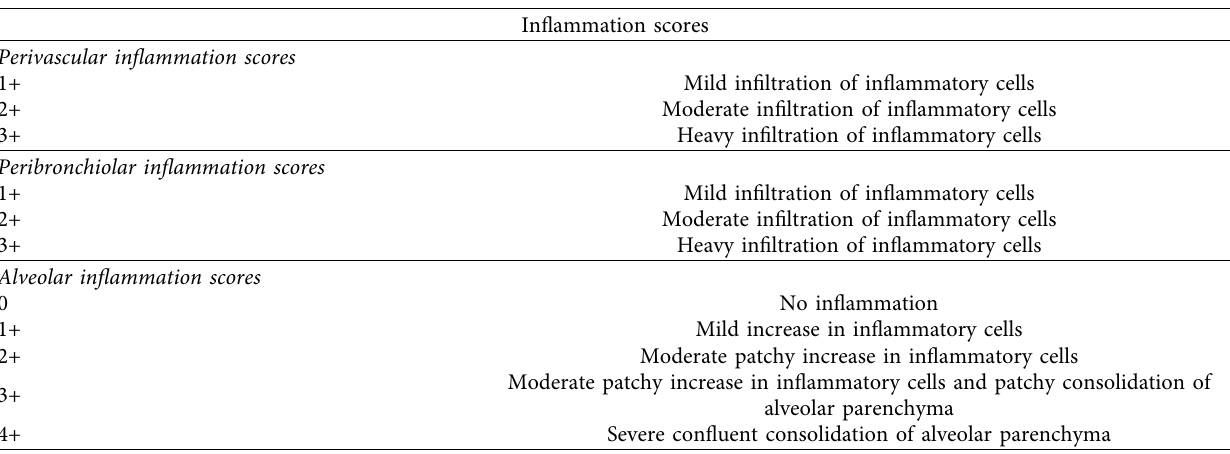
Figure 1: Te schematic diagram of bleomycin infusion protocols in sheep ( n � 8) and mouse ( n � 14) models. (a) In individual sheep ( n � 8), the left caudal lung segment received infusions of bleomycin, while the right caudal lung segment received the saline for controls. Tese infusions were repeated on day 14, and tissue samples were harvested on day 28. (b) For mice, there were two groups: one group of 7 animals ( n � 7) received bleomycin intranasally, and for controls, another group of 7 ( n � 7) received saline intranasally. Tese applications were repeated on day 7, and tissue samples were harvested on day 21. All the animals were kept for a 14-day resting period (pretreatment) prior to bleomycin Table 1: Infammation scores for the assessment of lung tissue damage.